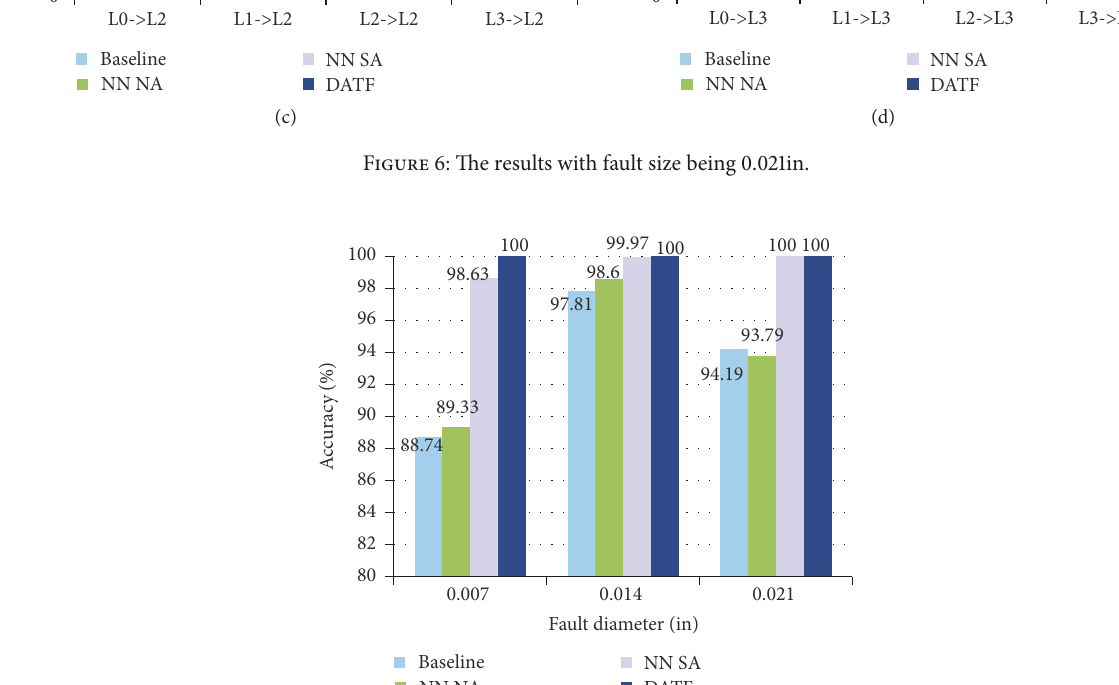
Figure 7: The average classification